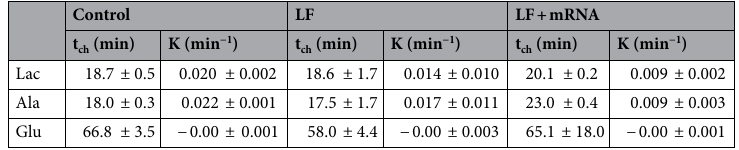
Table 1. Characteristic times (t ch ) and binding parameters (K) for metabolites. The characteristic time of the metabolic flux, t ch , is equal to 2/(1/t P + 1/t C ). The characteristic binding parameter that describes the rate for incorporation, k on [binding sites], of the labeled glucose into and release from the bound fraction, K, is equal to (1/t P —1/t C )/2. All errors are